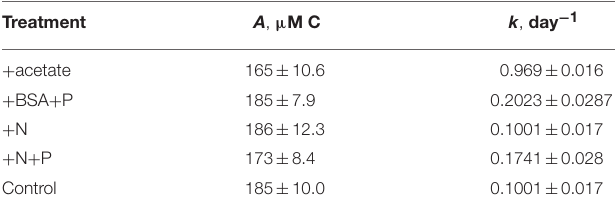
TABLE 2 | Modeled asymptotes ( A ) and rate constants ( k ) for 14 CO 2 production in each incubation. Treatment